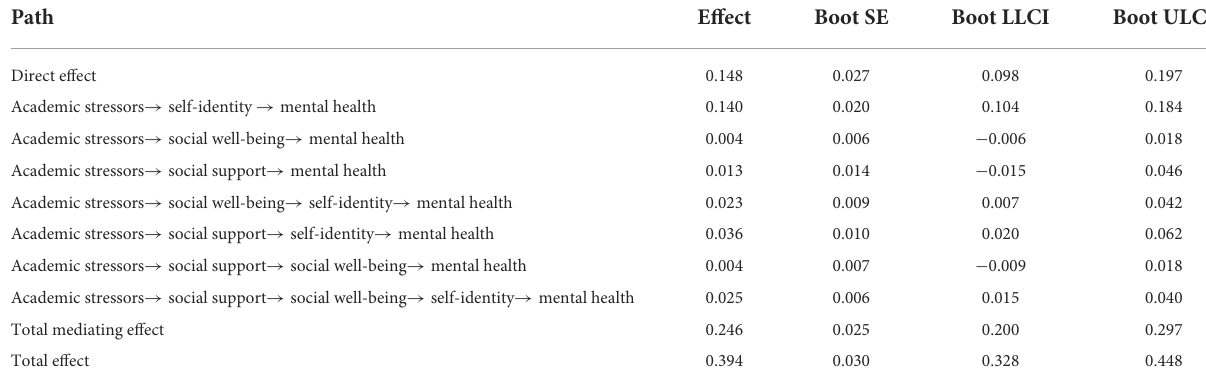
TABLE 5 The chain mediating effect of social support, social well-being and self-identity between academic stressors and mental health.